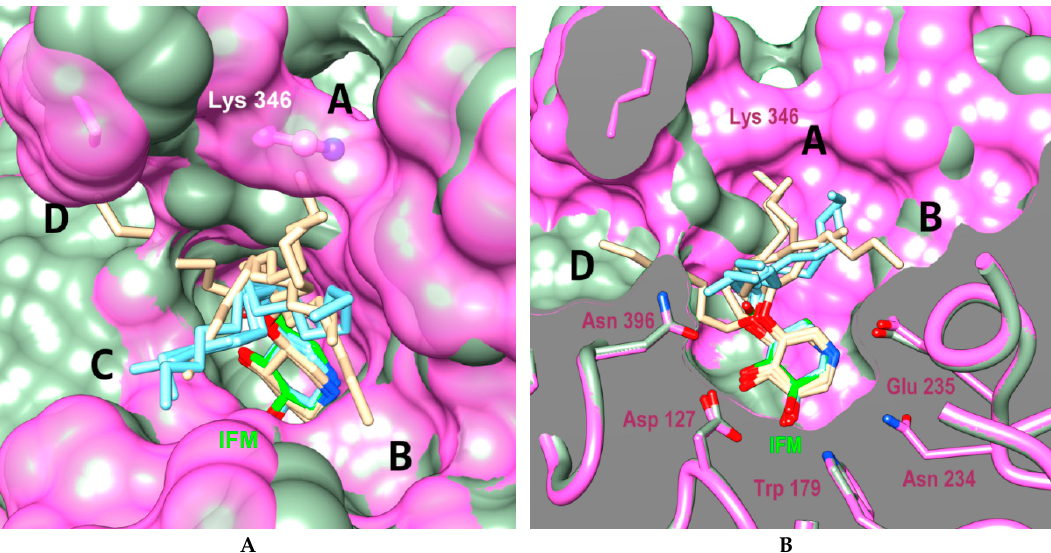
Figure 3. Combination of best docked poses for compound 8 using protocols P1-OPT (brown) and P2-GPU (cyan) in 2NSX (chain B, light green) and 2WCG (chain A, pink surface) binding cavity ( A : surface view, B : clipped view). The PDB ligand IFM (IFG) is shown in green in the bottom of active site and LYS346 residue of 2WCG is highlighted. Letters A to D reffer to the channels explored by the lipophilic chains.